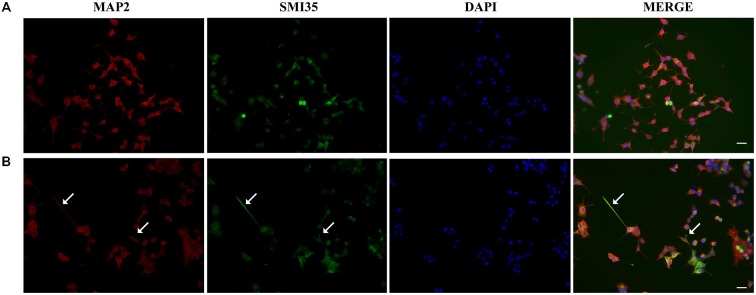
Blockage of proNGF binding to sortilin with NT promotes axon formation. Panels show immunofluorescence images of PC12 cells treated with (A) CM and (B) CM+NT for 13–14 days, double labeled with antibodies that recognize dendrites (MAP2, red) and axons (SMI35, green), DAPI was used to visualize the nucleus. Arrows point the axons. Scale bars = 20 μm.